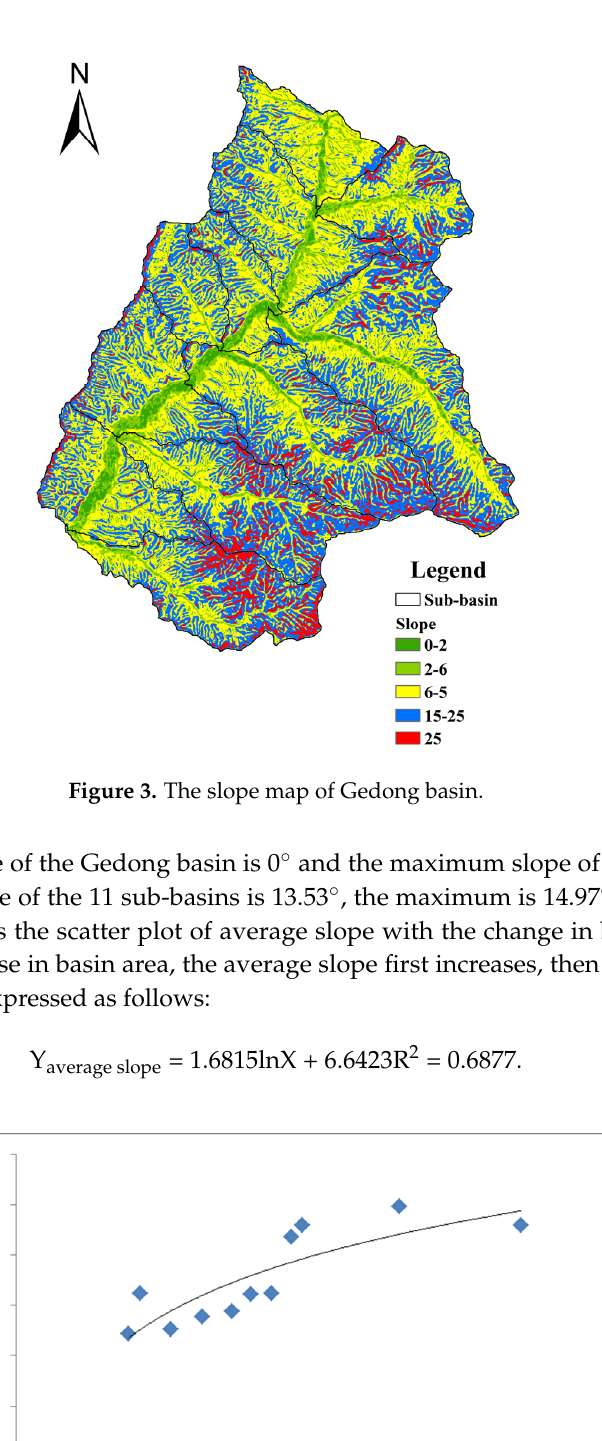
Figure 2. The land use types in Gedong basin.